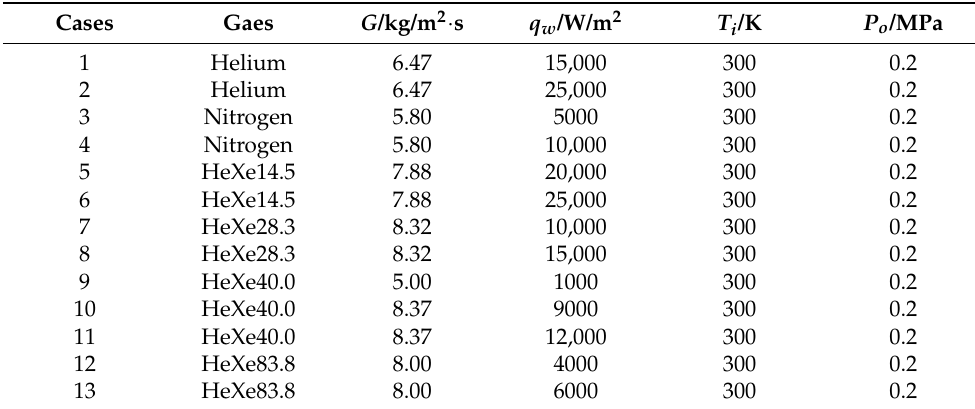
Figure 1. The calculation model of numerical simulation. Table 1. The boundary conditions of numerical simulation.